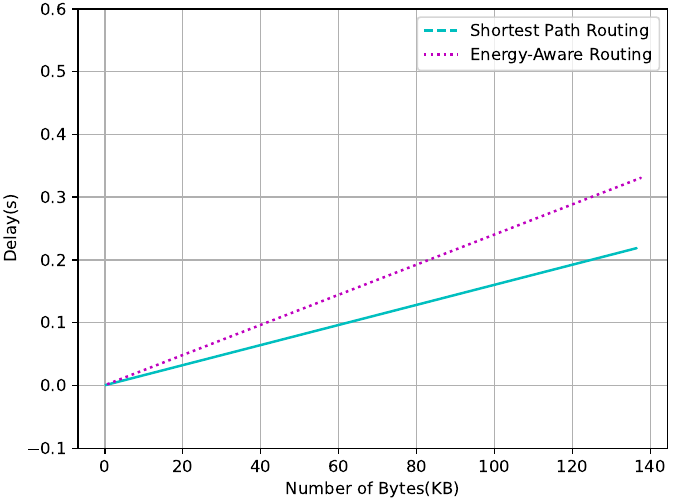
Figure 12. End-to-End Delay of Transmiited Bytes From Access Point 1 to Access Point